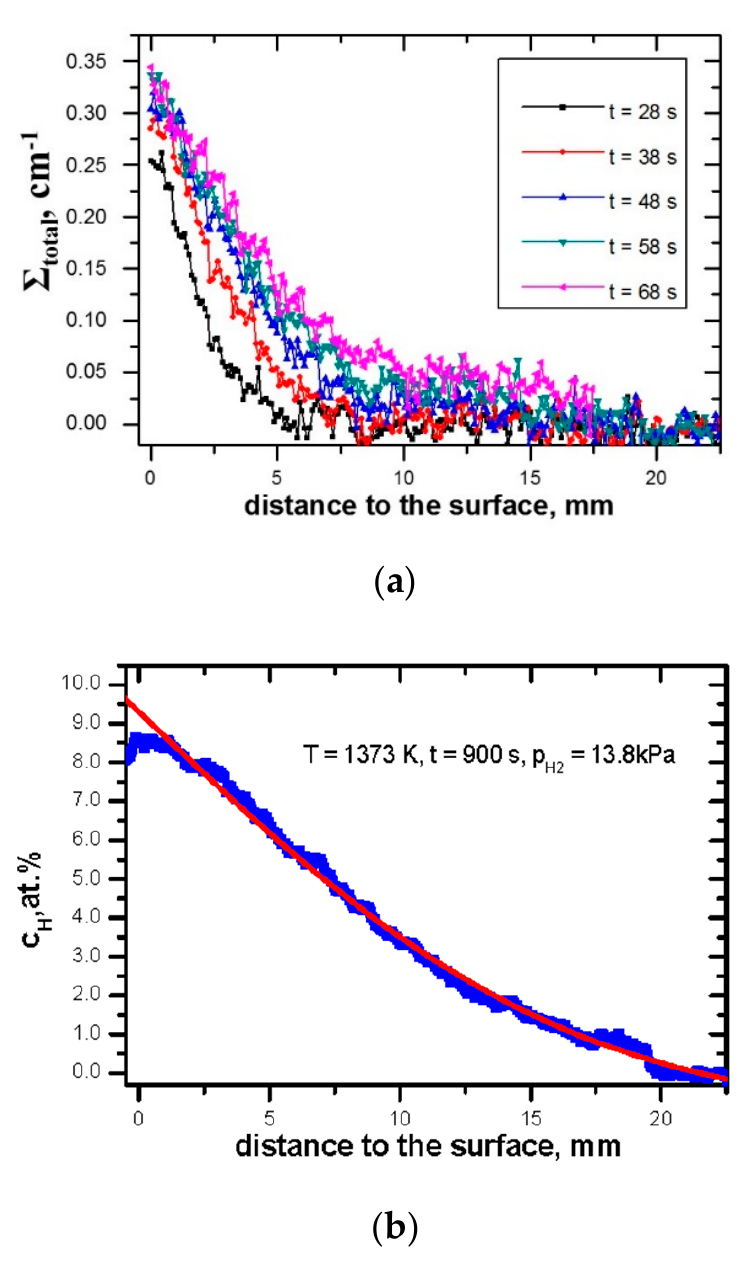
Figure 7. ( a ) Dependence of the total neutron cross section on the distance to the surface where the hydrogen penetrates at 1200 °C for annealing times between 28 and 68 s and ( b ) fit of the measured diffusion hydrogen distribution after 15 min annealing at 1100 °C with Equation (1). c ( x,t ) is the actual concentration, c 0 the constant concentration at the surface, x the distance to the surface, D the diffusivity, and t the time. This equation is valid as long as the hydrogen does not reach the opposite end of the sample. Because the total macroscopic neutron cross section depends linearly on the number density of hydrogen, no calibration of this dependence is needed to determine the diffusivity from the width of the distribution given by er f